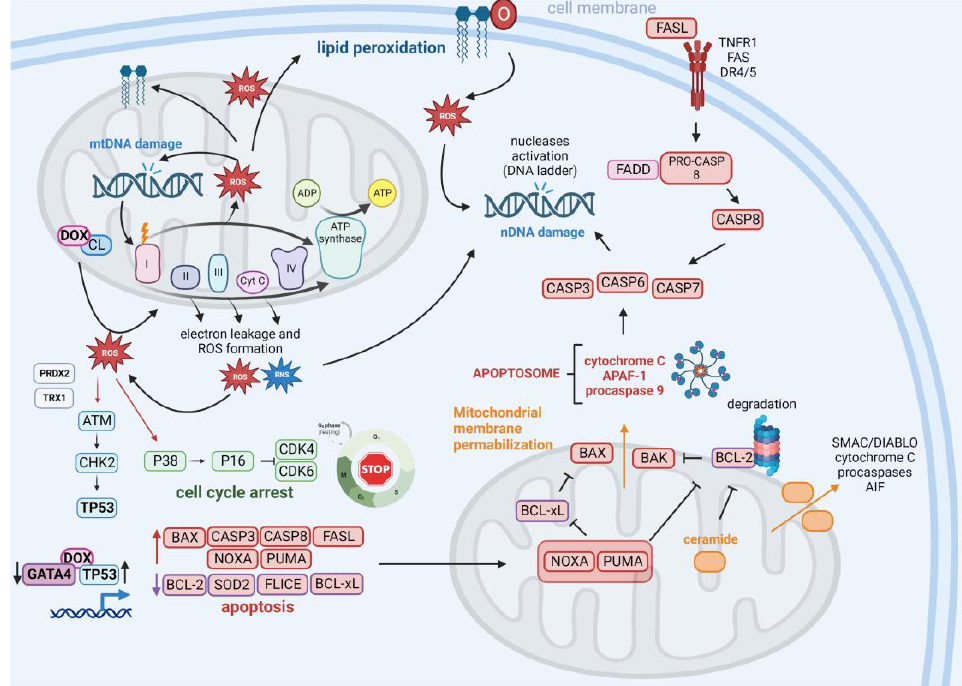
Figure 2. Contribution of DOX to ROS induction and apoptosis. The interaction of DOX with cardiolipin (CL) leads to the elevation of reactive oxygen species (ROS) and reactive nitrogen species (RNS) levels, which contribute to DNA damage of nuclear (nDNA) and mitochondrial DNA (mtDNA). DNA damage and mutations in mtDNA encoding proteins of the electron transport chain (ETC) lead to the production of defective ETC components that increase electron leakage and ROS/RNS generation. Alternatively, ROS trigger lipid peroxidation, enhancing ROS pools in the cells. ROS may trigger the activation of the ATM-CHK2-TP53 signaling independently of DNA damage through ROS- mediated ataxia telangiectasia mutated A-T mutated (ATM) dimer formation through modification of enzyme cysteine residues by peroxiredoxin-2 (PRDX2) and thioredoxin-1 (TRX1). Through the P38 protein, ROS may activate the P16 protein, which works as an inhibitor of cyclin-dependent kinases 4/6 (CDK4/CDK6). DOX increases the expression of cellular tumor antigen p53 (TP53) and down-regulates the expression of GATA binding protein 4 (GATA4), which influences the expression of genes under the control of these transcription factors. Consequently, an increase in multiple proapoptotic proteins (including BAX, caspase 3/8 (CASP3/8), FAS antigen ligand (FASL), phorbol- 12-myristate-13-acetate-induced protein 1 (NOXA), and isoform 1 of Bcl-2-binding component 3, isoforms 1/2 (PUMA)) is observed in addition to a decrease in antiapoptotic factors (such as cyclin D1, B-cell lymphoma-extra large (BCL-xL), and FLICE). The observed down-regulation of BCL-xL and apoptosis regulator Bcl-2 (BCL-2) activity can be attributed to the inhibitory activity of NOXA and PUMA and the antiapoptotic protein proteasomal degradation. Alternatively, activation of ceramide signaling together with mitochondrial pore formation (through BAX and BAK proteins) and the loss of mitochondrial integrity confer the release of proapoptotic factors including cytochrome c, apoptotic protease-activating factor 1 (APAF1), and procaspase-9 (leading to apoptosome formation), the secondary mitochondria-derived activator of caspases (SMAC)/direct inhibitor of apoptosis-binding protein with low pI (DIABLO), apoptosis-inducing factor 1, mitochondrial (AIF), and pro-caspases. Apoptosome activity contributes to the activation of effector caspases (CASP3, -6, and -7) that execute the final phase of apoptosis and lead to the activation of nucleases that cleave nDNA (leading to DNA laddering observed following treatment of cells with DOX). DOX also induces the extrinsic apoptosis pathway via up-regulation of FASL, its interaction with the death receptors tumor necrosis factor receptor 1 (TNFR1), FAS, and death receptor 5 (DR5), and activation of CASP8 and effector caspases. Created with BioRender.com accessed on 1 January